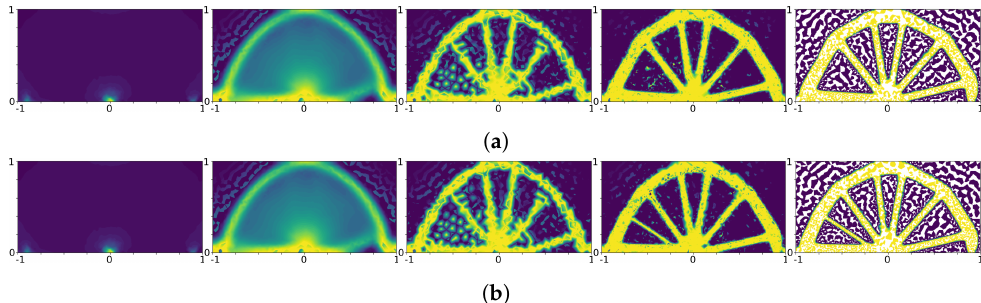
Figure 6. Classical risk-averse stochastic optimisation ( top ) and N CNN accelerated ( bottom ). ( a ) Sequence ϕ 1 , ϕ 100 , ϕ 200 , ϕ 400 , ϕ 517 from Algorithm 2. ( b ) Sequence ϕ 1 , ϕ 100 , ϕ 200 , ϕ 400 , ϕ 490 from Algorithm A2.